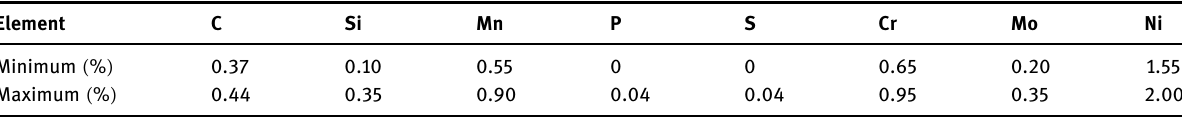
Table 4: Chemical compositions of AISI 4340 [ 19 ] Element